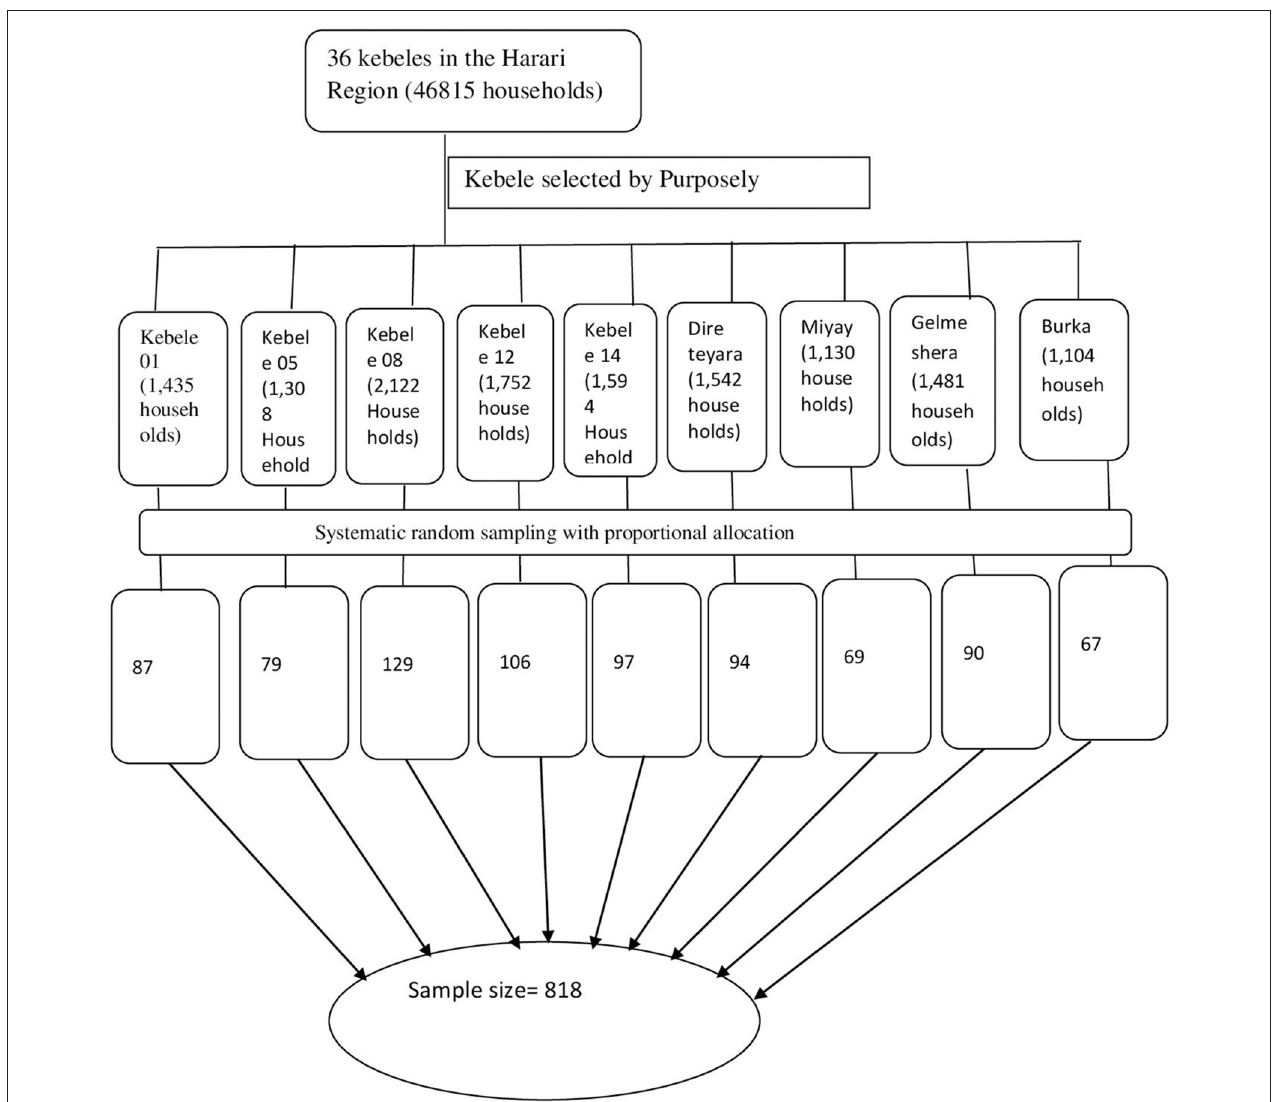
FIGURE 1 | Multistage sampling which shows the sampling procedure to draw the study participants from source population.